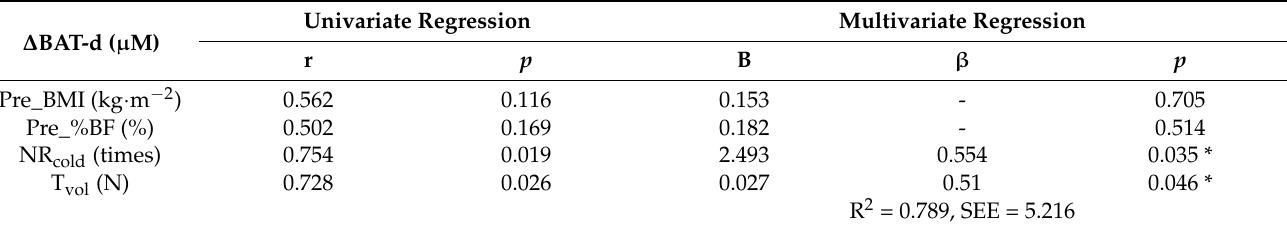
Table 4. Multiple linear regression analysis for ∆